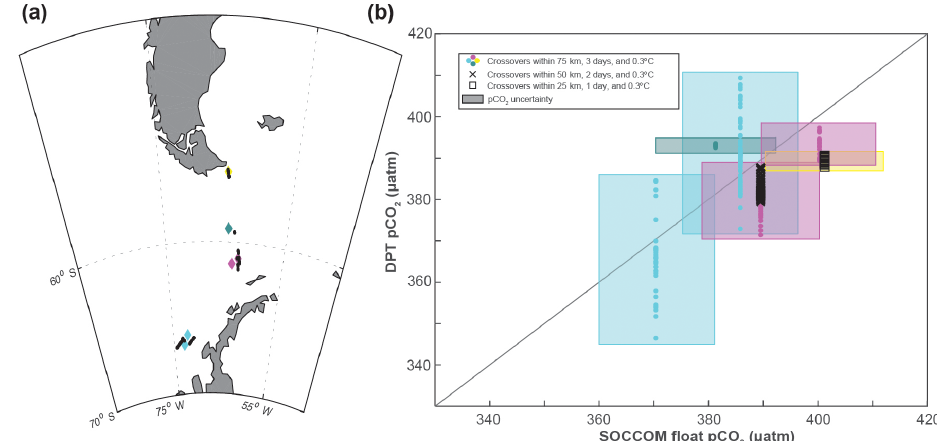
Figure 9. (a) Map of SOCCOM floats with DPT crossovers within 75km, 3 days, and 0.3 ◦ C SST from coincident surface observations. (b) Calculated p CO 2 from the SOCCOM float ( x -axis) versus DPT underway p CO 2 observations ( y -axis) for crossover float locations, with a 1 : 1 line. Colors correspond to the float number in Fig. 7. Horizontal width of shading represents SOCCOM relative standard uncertainty, which is estimated at ± 2 . 7%µatm; vertical shading is ± 2µatm. Black “x” and squares indicated crossovers within a smaller window (50km/2day/0.3 ◦ CSST and 25km/1day/0.3 ◦ CSST,